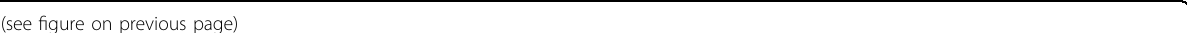
Fig. 3 PLK1 phosphorylates BEX4 and regulates its subcellular localization during mitosis. a HeLa cells were transfected with shLuc, shBEX4, shCDK1, or shPLK1 and cultured in the presence of nocodazole (200ng/ml) for 16 h. The cells were collected by shake-off, then lysed and immunoblotted with anti-PLK1, anti-CDK1, anti-BEX4, and anti- β -actin. Expression levels relative to respective controls are shown below the blots. b HeLa cells were transfected with control shLuc or PLK1-targeting shRNA, cultured on coverslips for 24 h and stained with anti-aurora A (Aur A), anti- BEX4, and DAPI. The metaphase cells were then analyzed. Scale bars represent 5 μ m. c HeLa cells were cultured on coverslips for 24 h, then treated with BI2536 (300 nmol/l; a selective PLK1 inhibitor) or DMSO as the control. At 2 h post-treatment, the cells were fi xed with 4% paraformaldehyde and stained with anti-BEX4 and anti-aurora A (Aur A) antibodies. DNA was visualized by DAPI staining. The insets show magni fi ed images of centrosomes. Scale bars represent 5 μ m. d HeLa cells were transfected with shLuc or shPLK1. At 36 h after transfection, the cells were treated with cycloheximide (CHX) for the indicated times and then subjected to immunoblotting with anti-BEX4, anti-PLK1, and anti-actin antibodies. e , f All serine (S) and threonine (T) residues in human BEX4 protein. HeLa cells were transfected with GFP-fused BEX4 mutant constructs with serine and/or threonine substituted with alanine (S3A, T29A, S35A, T94A, or T107A), or a BEX4 wild-type construct. The expression of each BEX4 expression construct was analyzed by immunoblotting using anti-GFP, anti-BEX4, and anti-actin antibodies ( e ). Cells were fi xed with 4% paraformaldehyde and stained with anti-GFP and anti-aurora A (Aur A) antibodies. DNA was visualized by DAPI staining ( f ). The insets show magni fi ed images of the centrosomes. Scale bars represent 5 μ